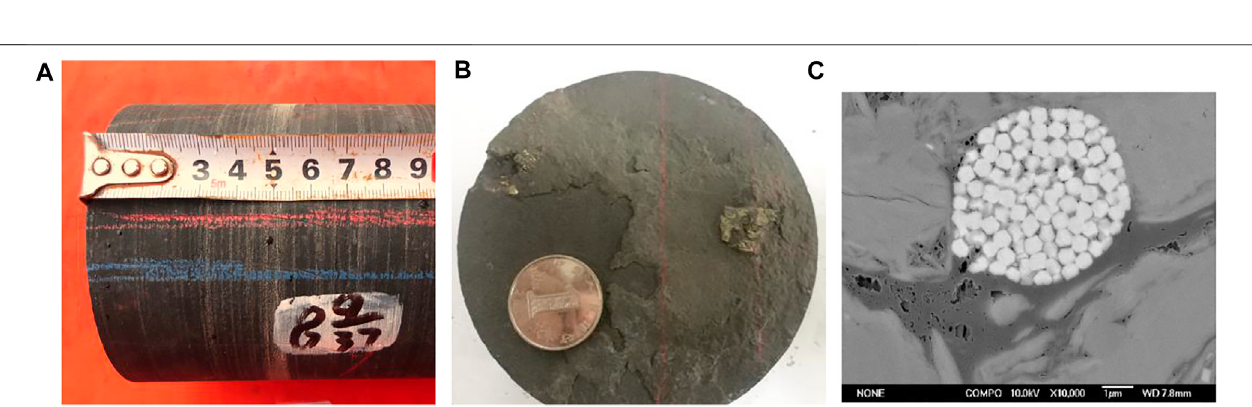
FIGURE 4 | Different types of pyrites: (A) striped pyrite; (B) patchy pyrite; and (C) strawberry-shaped pyrite.